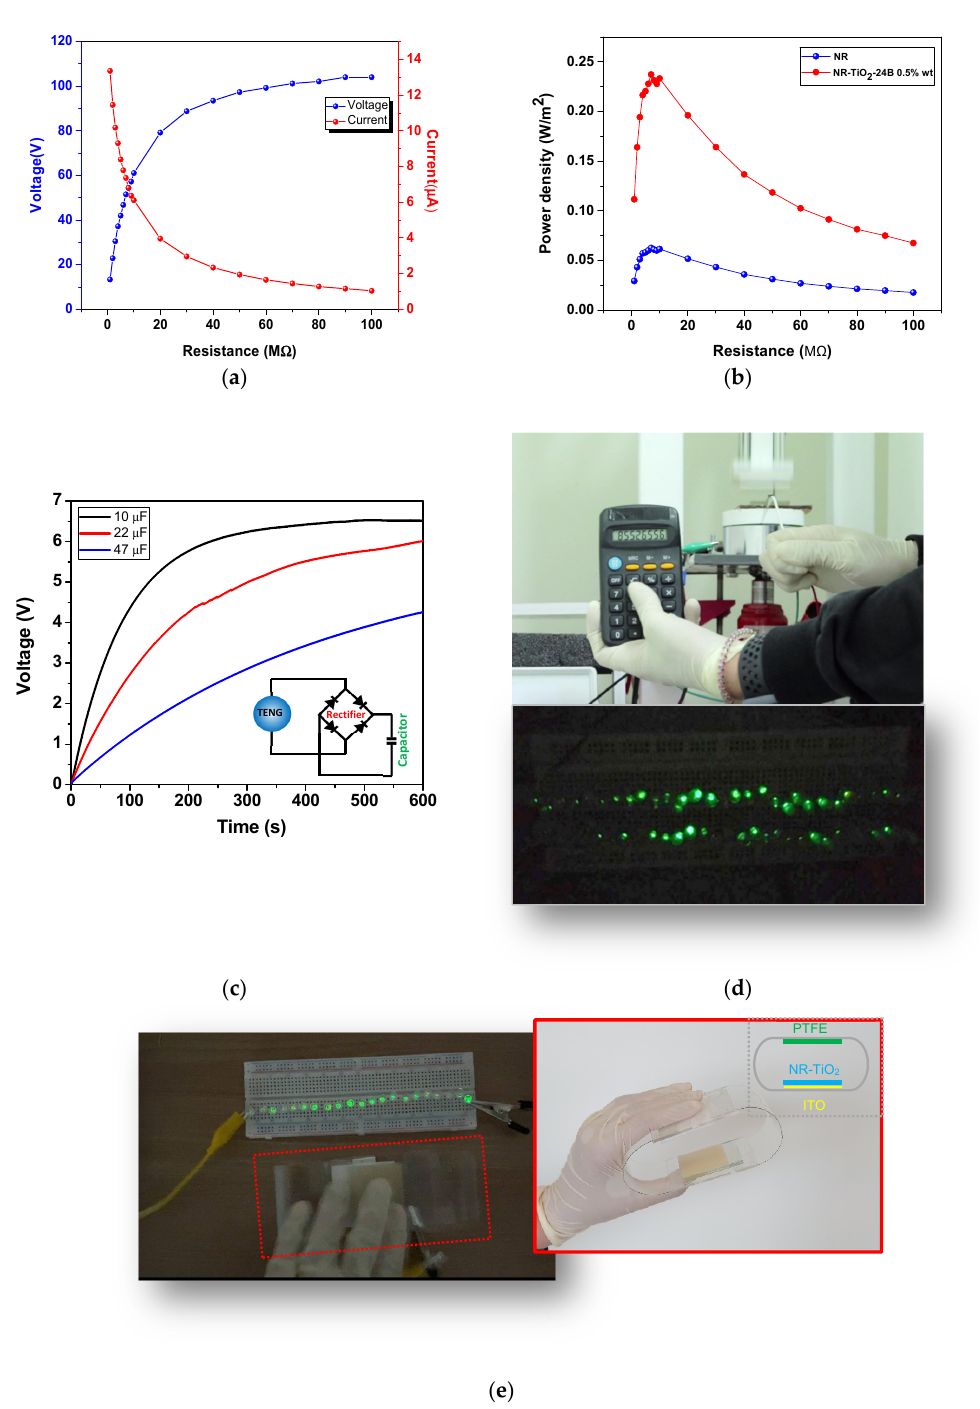
Figure 10. ( a ) The plot of voltage and current output versus load resistance and ( b ) Power density of the NR-TiO 2 -B24h 0.5%wt TENG compared to NR TENG. ( c ) Voltage profile of TENG to charge up the 10, 22, and 47 µF capacitors. ( d ) The demonstrations of TENG to operate a portable calculator (top) and to light up 60 green LEDs (bottom). ( e ) The fabricated TENG device able to light up 21 green LEDs by hand pressing with the inset showing a schematic diagram of device components.